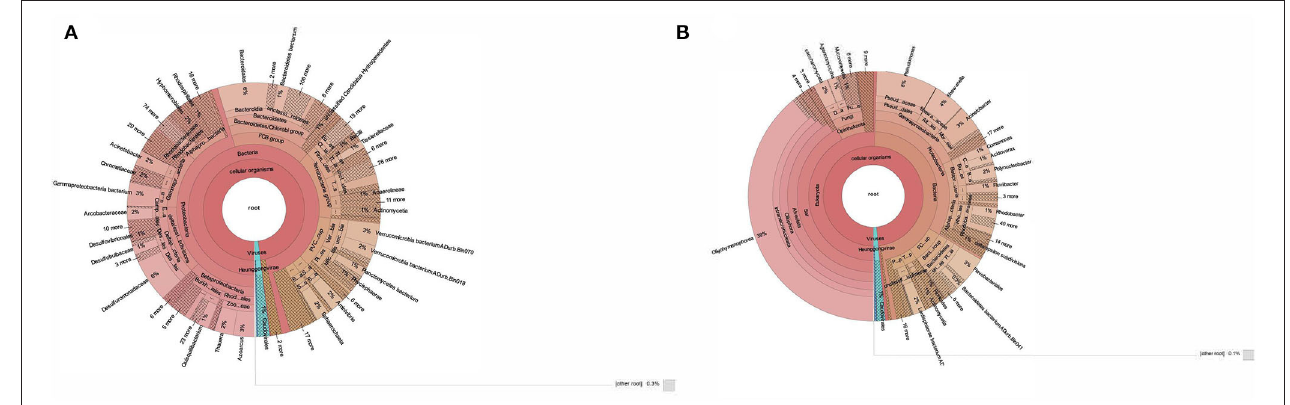
FIGURE 1 | (A) Taxonomic classification of BS14 at the genus level in krona plot. (B) Taxonomic classification of SR1 at the genus level in krona plot.